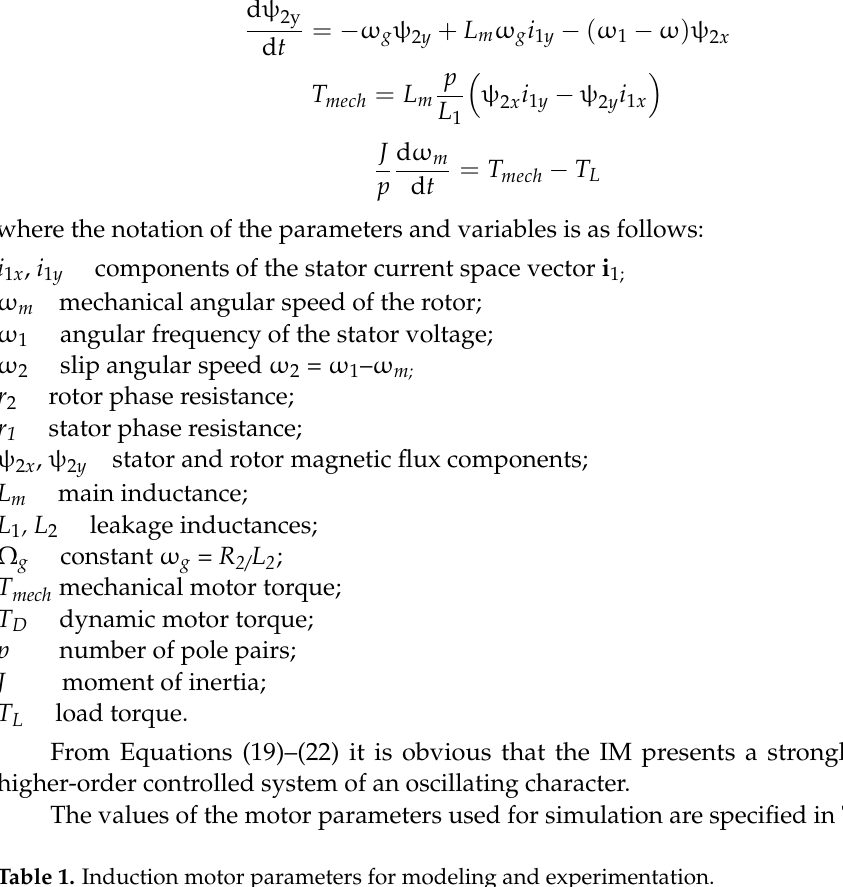
Table 1. Induction motor parameters for modeling and